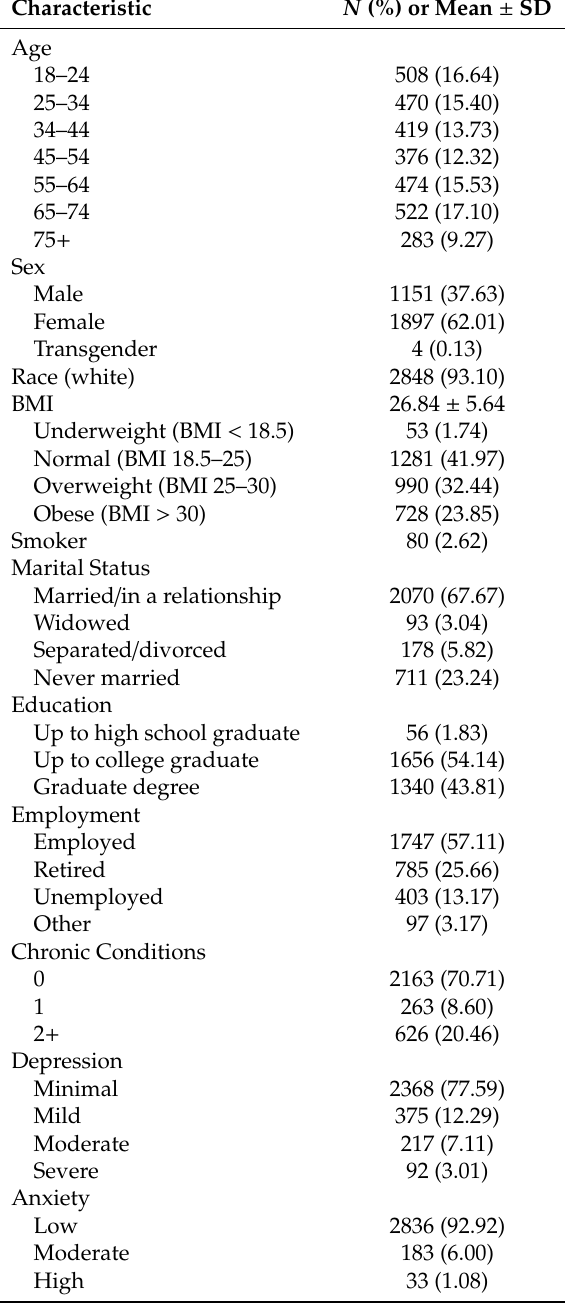
Table 1. Participant characteristics ( n =